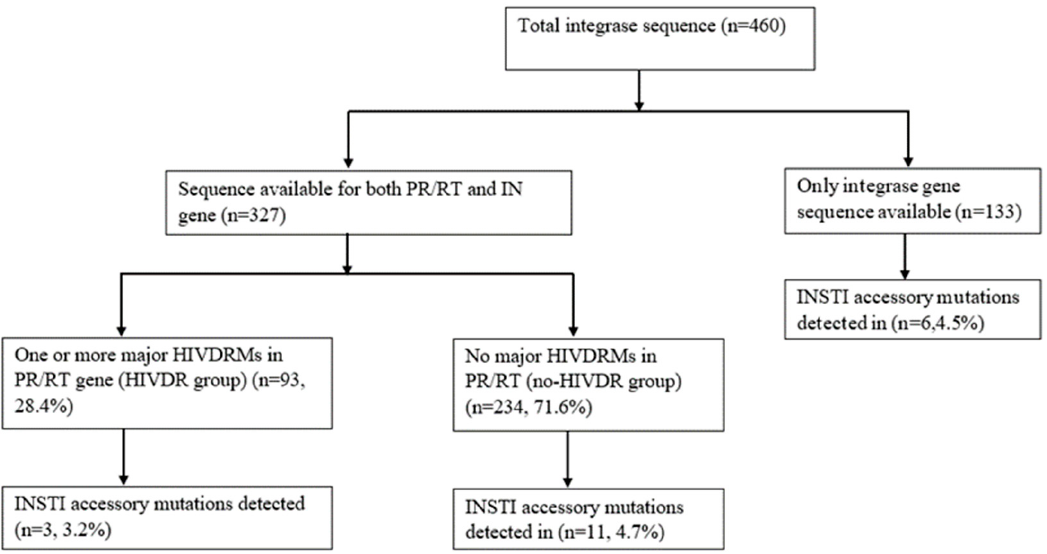
Figure 2. Flow chart of study-participant selection and INSTI drug resistance among INSTI-naïve